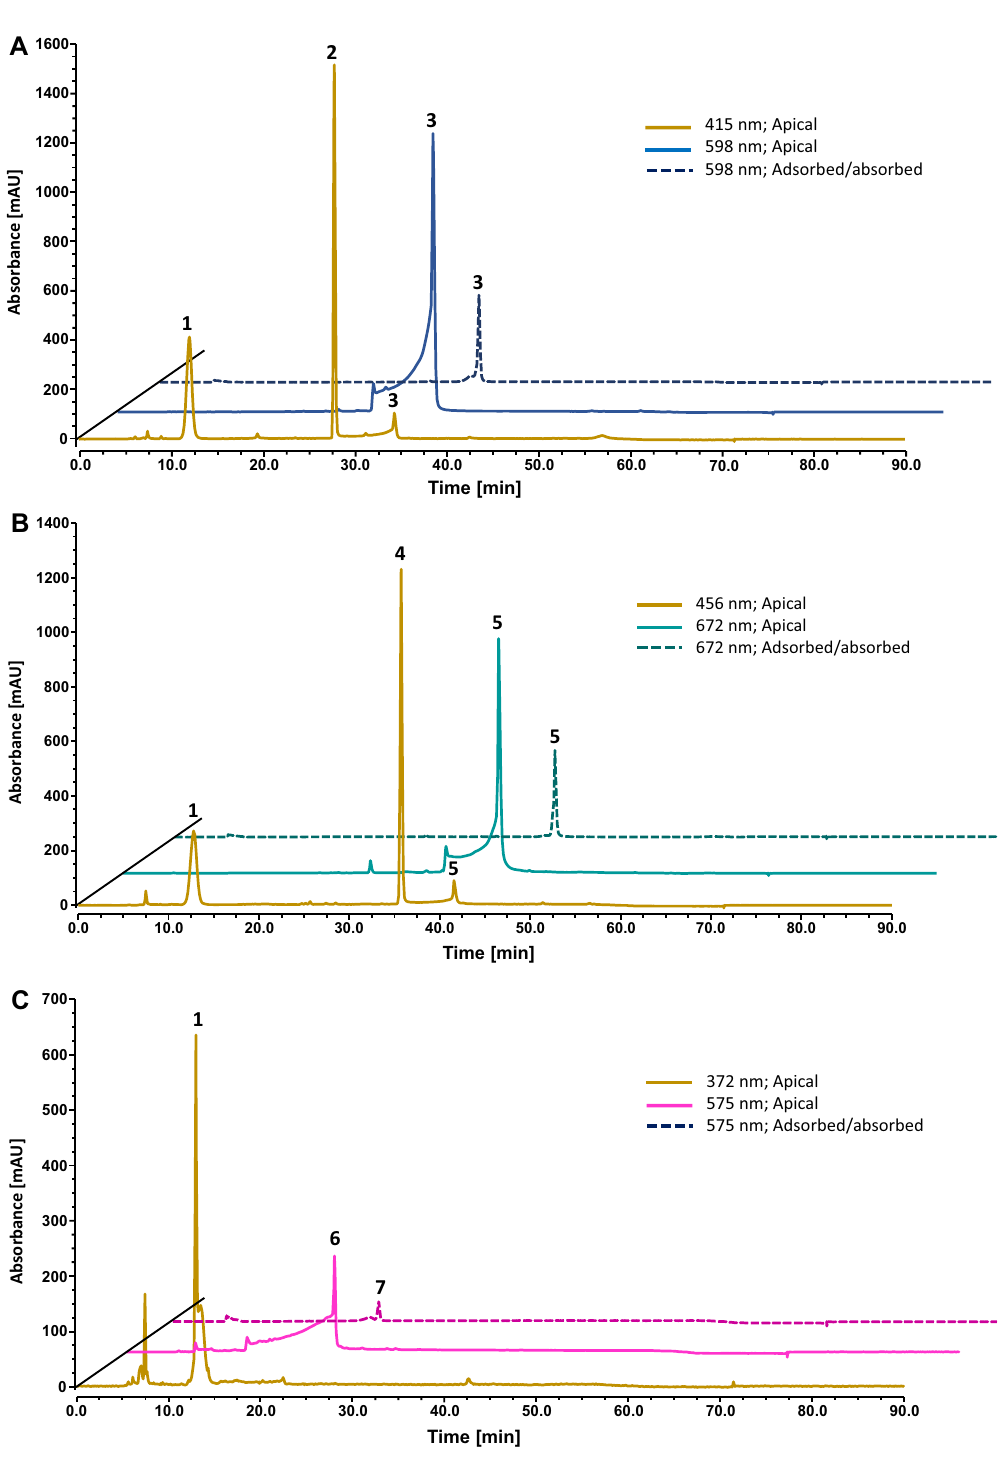
Figure 6. Chromatographic representation of ( A ) 7NEt 2 4 ′ NMe 2 (100 μM), ( B ) 7NEt 2 st4 ′ NMe 2 and ( C ) 7NEt 2 4 ′ NH 2 in the studies of the cellular uptake: compounds species present at the apical side in DMEM 2% FBS after 4 h in contact with HaCaT recorded at chalcone form maximum wavelength and at flavylium form maximum wavelength. Compounds forms adsorbed/absorbed by HaCaT cells after 4 h of incubation, at their maximum wavelength are presented as a dotted line. At the bottom of the figure is summarized the tentatively identification of all peaks by LC-DAD/ESI–MS